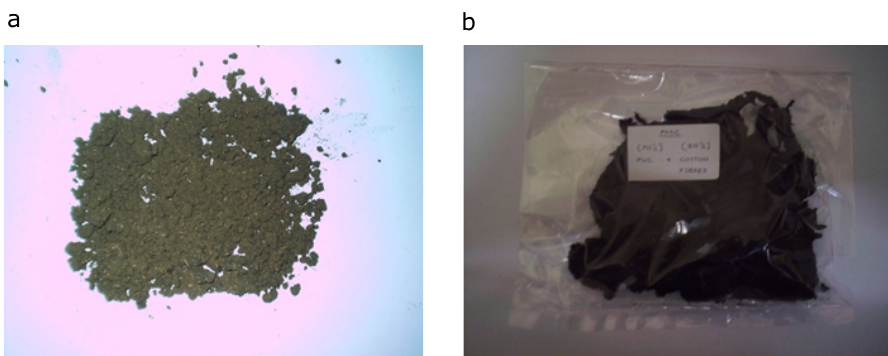
Figure 1. ( a ) Cotton fiber before being incorporated into polymers, and ( b ) a molded sample from the blending machine.